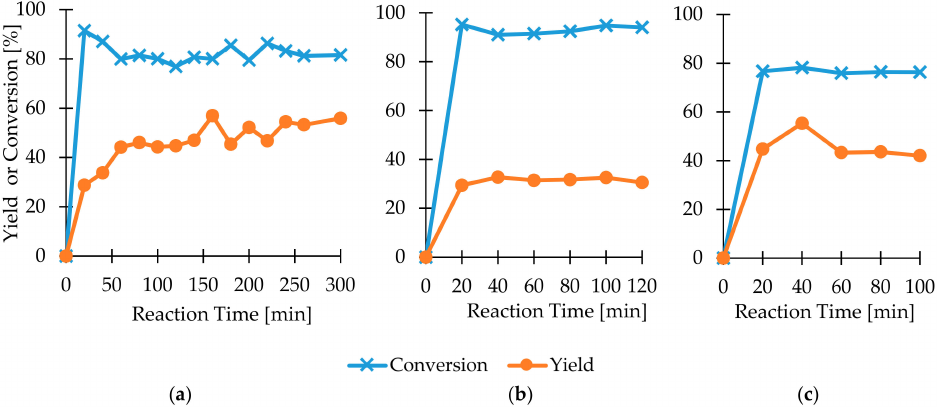
Figure 3. Results of the tandem experiments in continuous flow; ( a ) synthesis of 4-hydroxystilbene 4 , conversion of vinylphenol 2 (crosses) and yield (circles); ( b ) synthesis of resveratrol 6 , conversion of vinylphenol 2 (crosses) and yield (circles); ( c ) synthesis of pterostilbene 8 , conversion of vinylphenol 2 (crosses), and yield